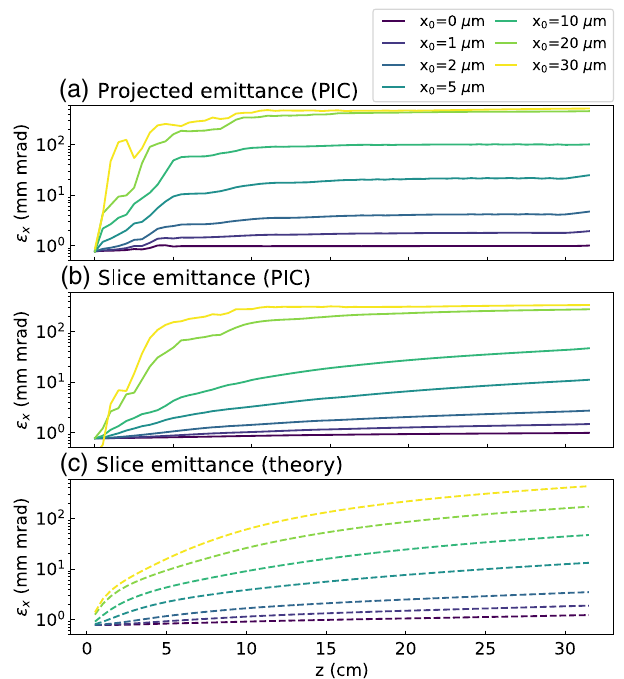
FIG. 5. Emittance growth along propagation due to electron beam misalignment. The initial transverse beam offset X 0 between 0 and 30 μ m. The laser pulse propagates on axis. Simulation conditions are given in Table I. (a) – (c) show the projected emittance in PIC simulations, slice emittance in PIC simulations, and theoretical predictions for the slice emittance,